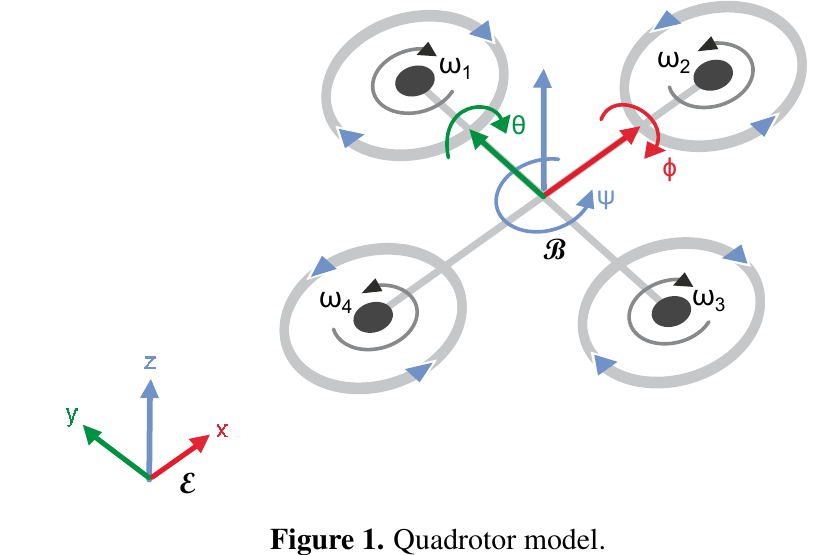
Figure 1. Quadrotor